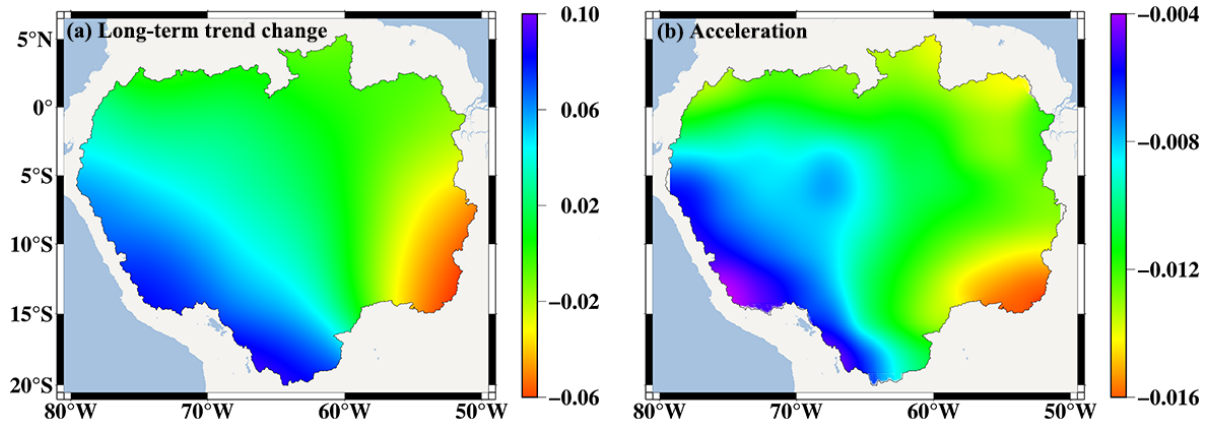
Figure 9. The long ‐ term trend changes and acceleration of GRACE/Swarm ‐ DSI in the ARB